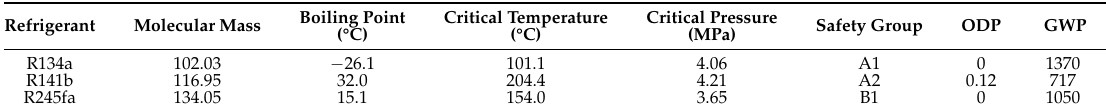
Table 1. Thermophysical prosperities, safety and environmental data of the tested working fluid.